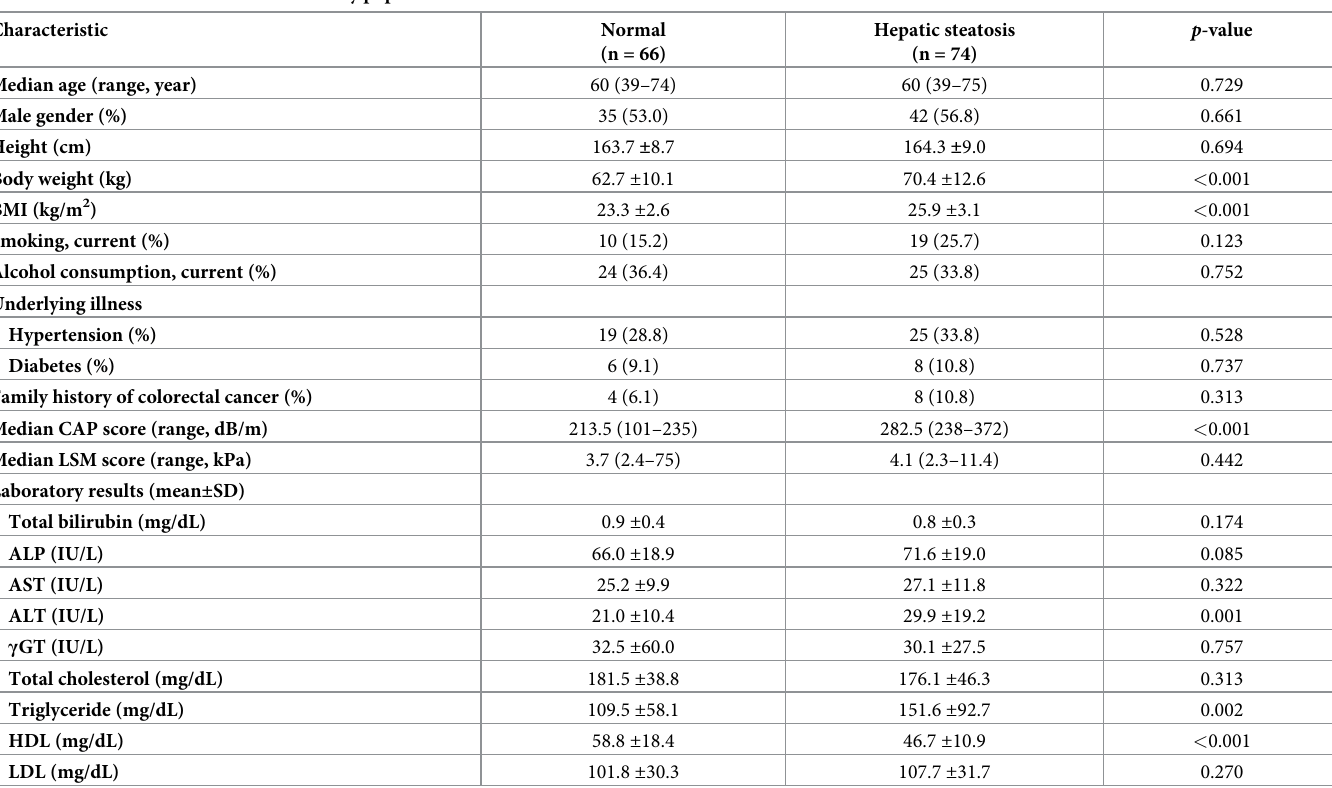
Table 1. Baseline characteristics of the study population.